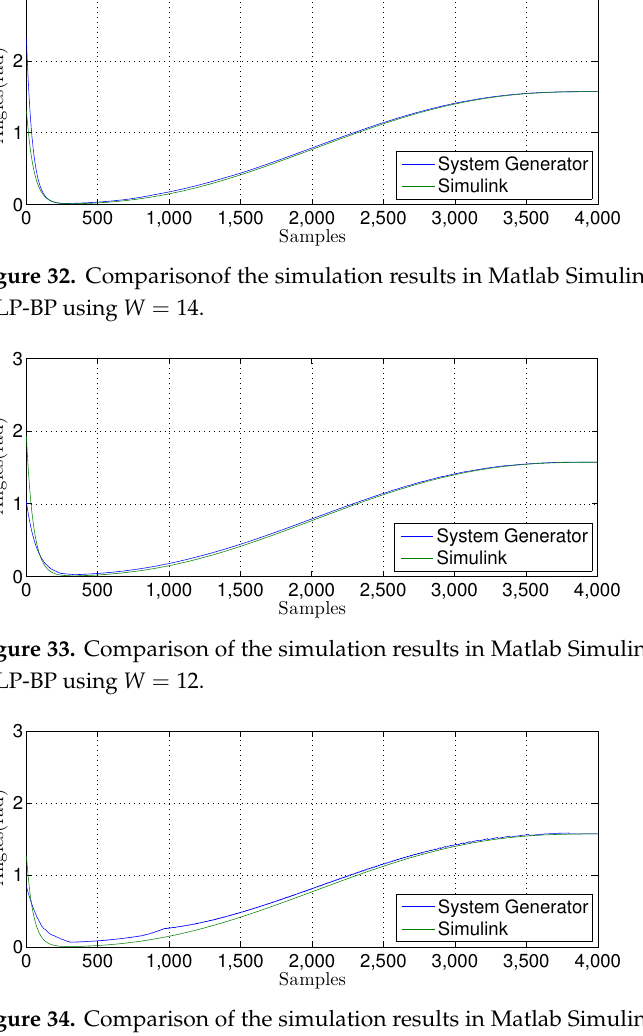
Figure 34. Comparison of the simulation results in Matlab Simulink and system generator for the MLP-BP with W = 10.